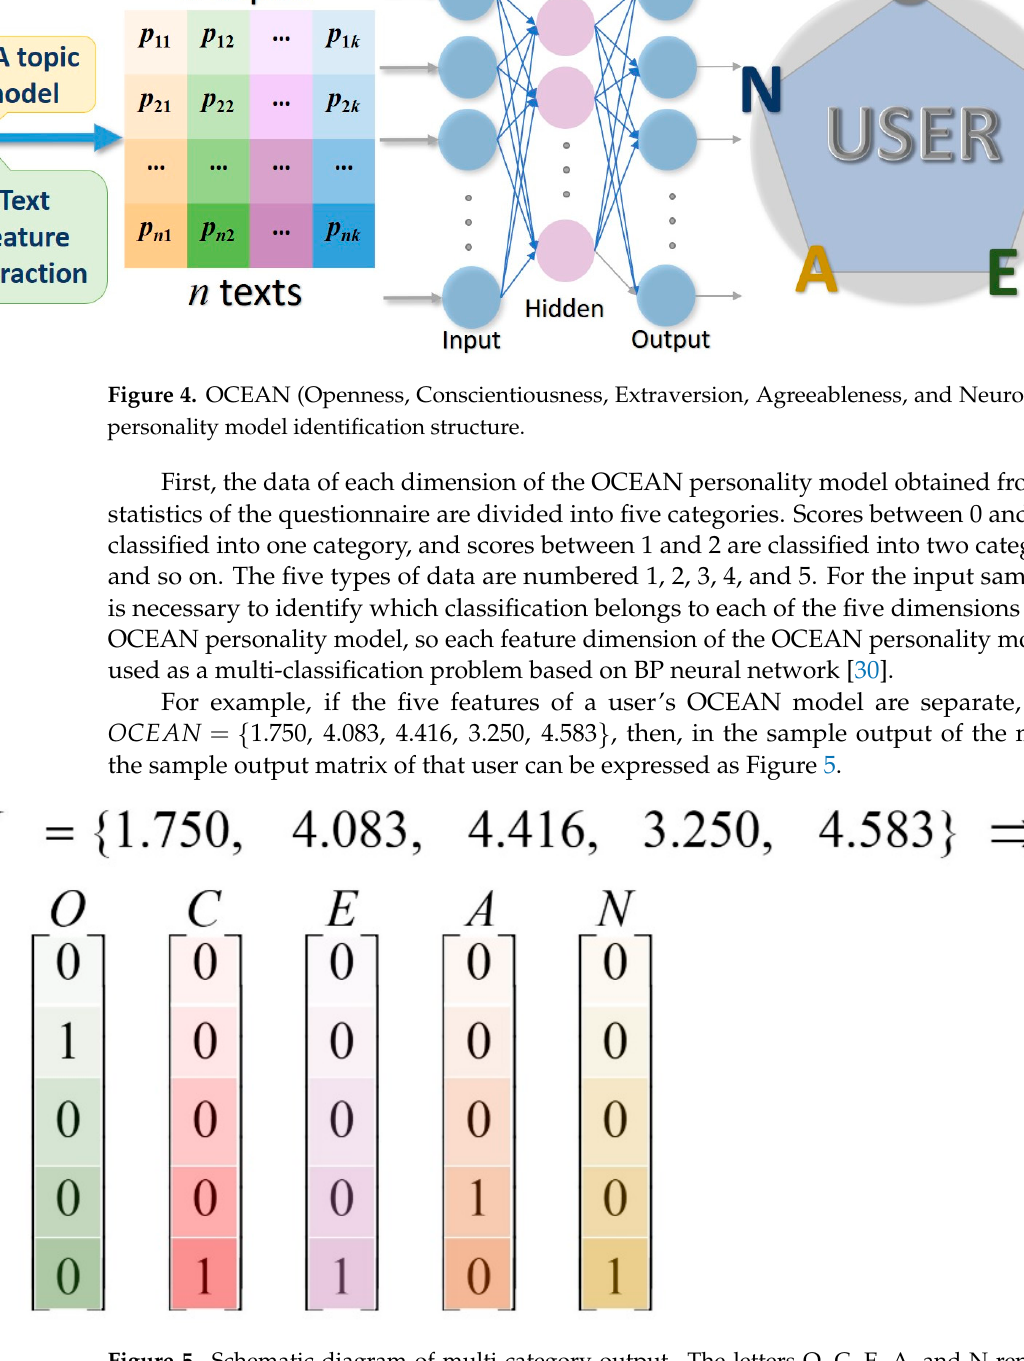
Figure 4. OCEAN (Openness, Conscientiousness, Extraversion, Agreeableness, and Neuroticism) personality model identification structure.